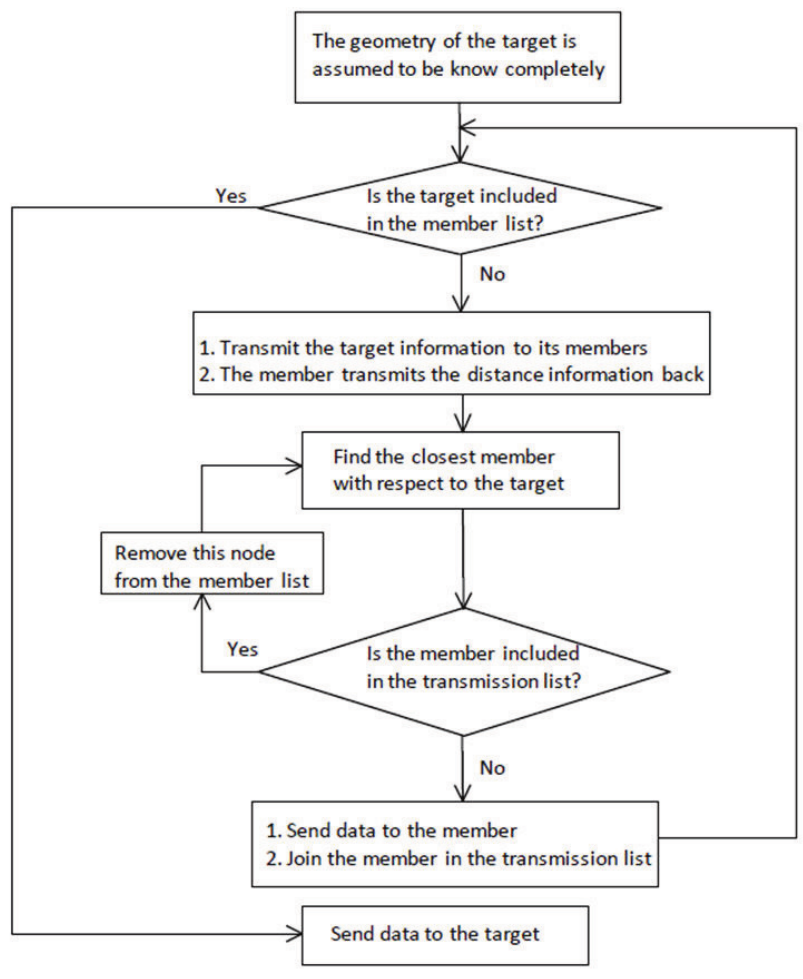
Figure 7. Flow diagram of Phase II: Determining the routing group